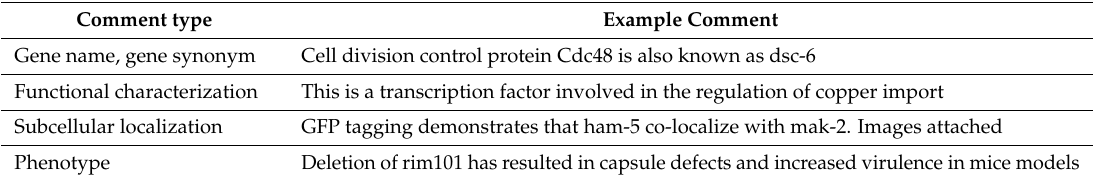
Table 2. Examples of user